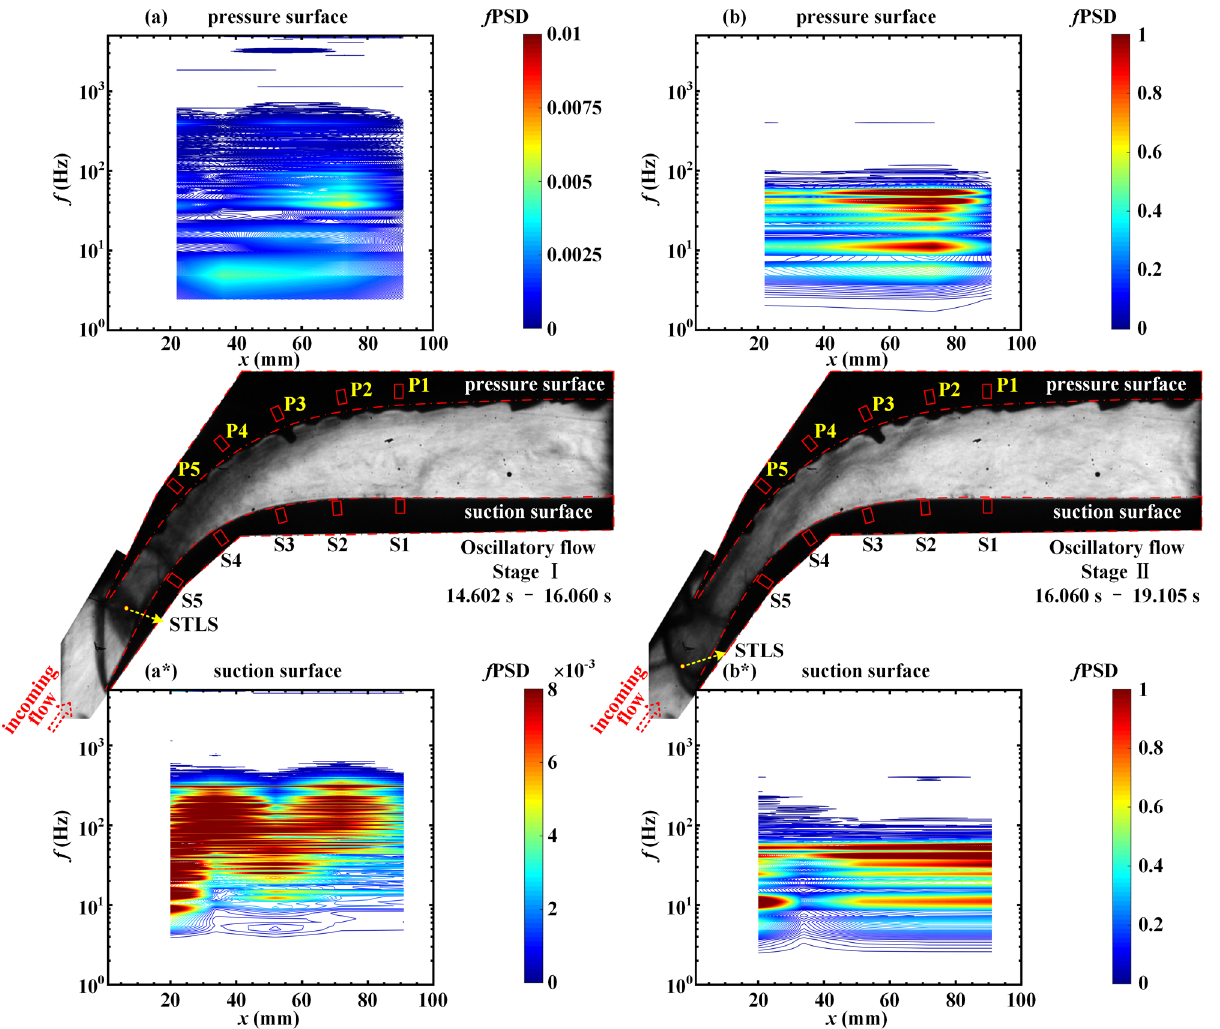
Figure 9. Contours of f PSD at the ( a ) pressure surface and ( a* ) suction surface in the oscillatory flow during the period 14.602 s < t < 16.060 s. Contours of f PSD at the ( b ) pressure surface and ( b* ) suction surface in the oscillatory flow during the period 16.060 s < t < 19.105 s.